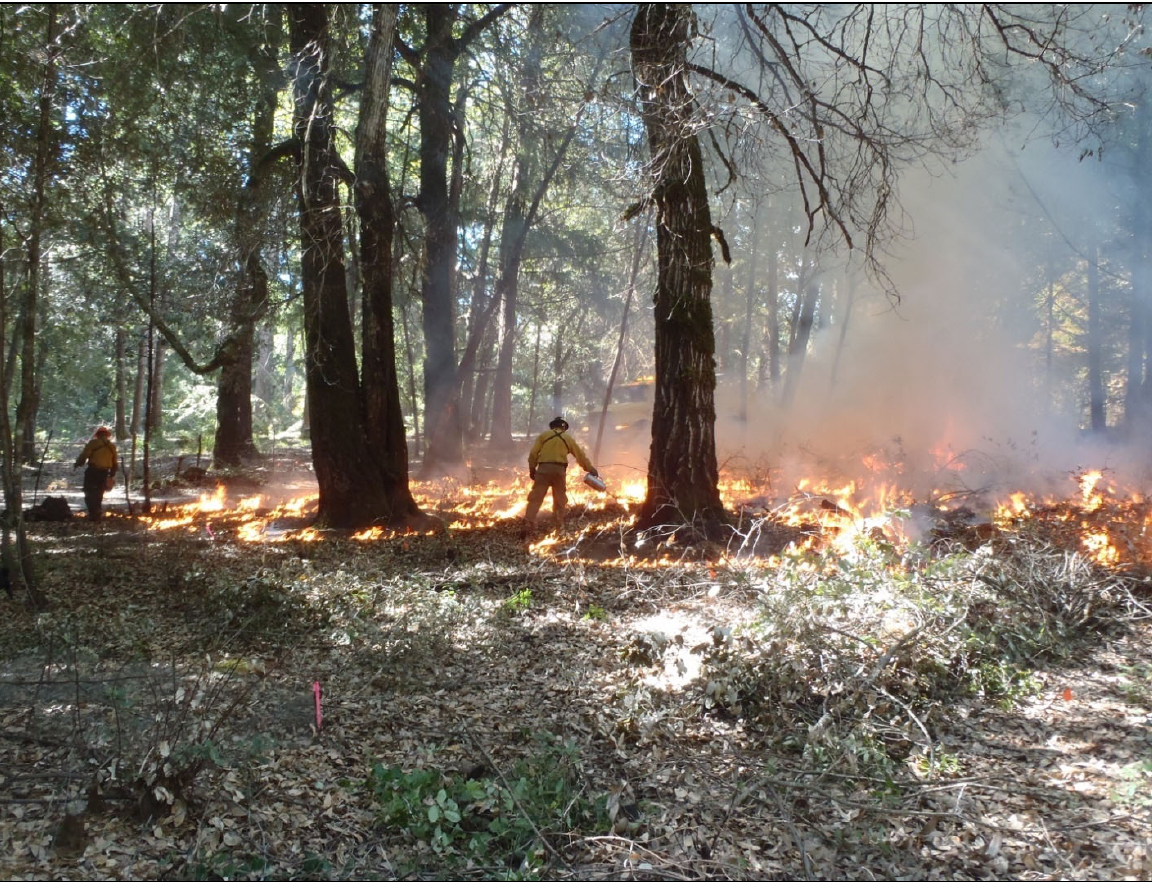
Photo Credit: Lake U.S. Forest Service and Karuk